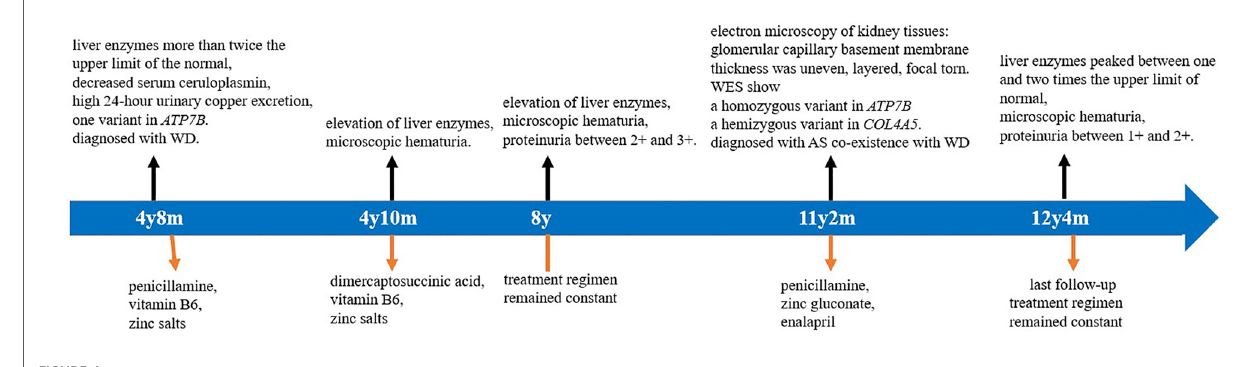
FIGURE 4 Timeline of clinical course, diagnostics, and treatment regimen of the patient. WES, whole-exome sequencing; AS, Alport syndrome; and WD, Wilson ’ s